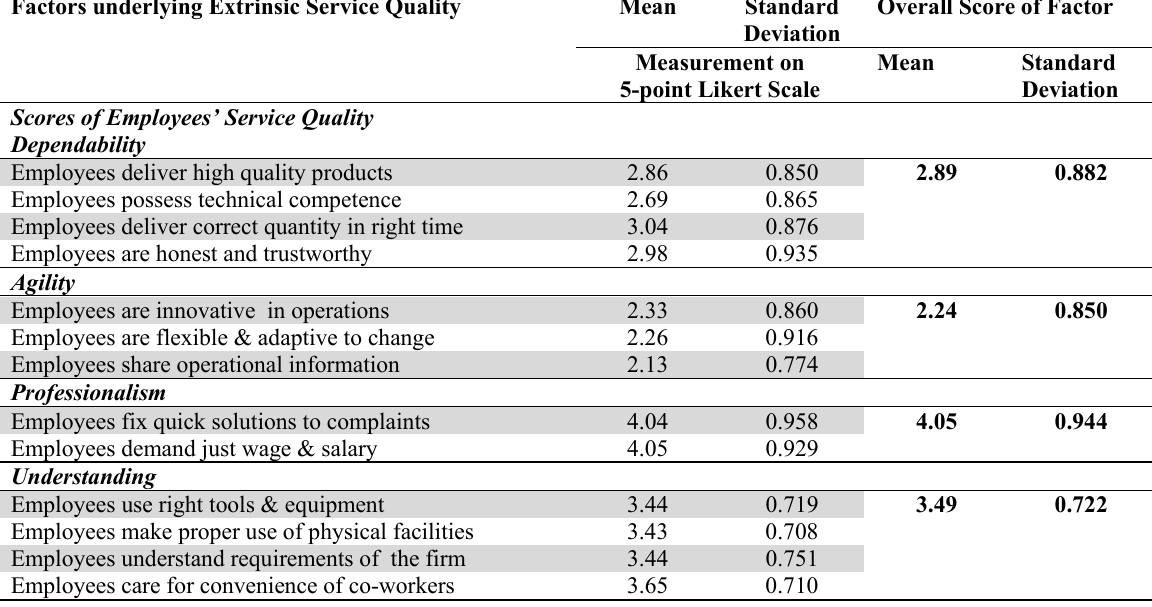
Summary Statistics of Factor Scores of Employees’ Service Quality (N=144) Factors underlying Extrinsic Service Quality Mean Standard